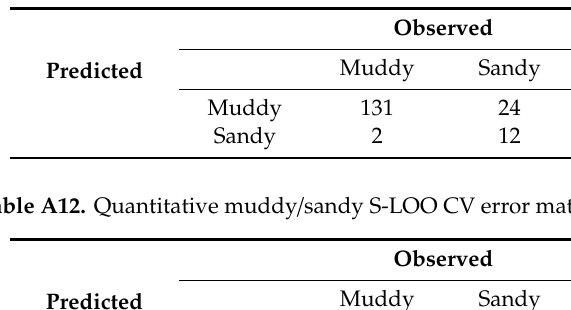
Table A11. Quantitative muddy / sandy LOO CV error matrix.